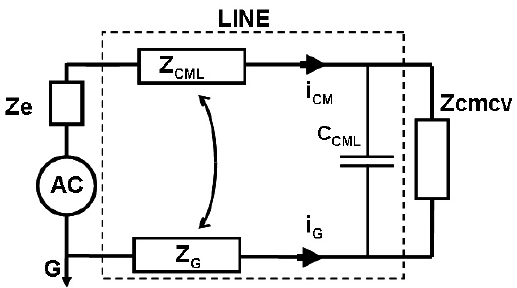
Figure 18: Experimental waveform of the current i